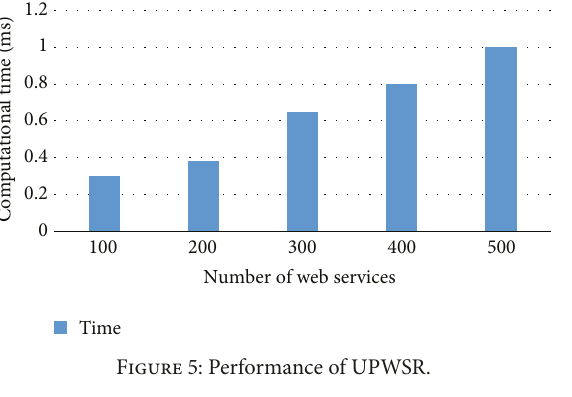
Figure 5: Performance of UPWSR.